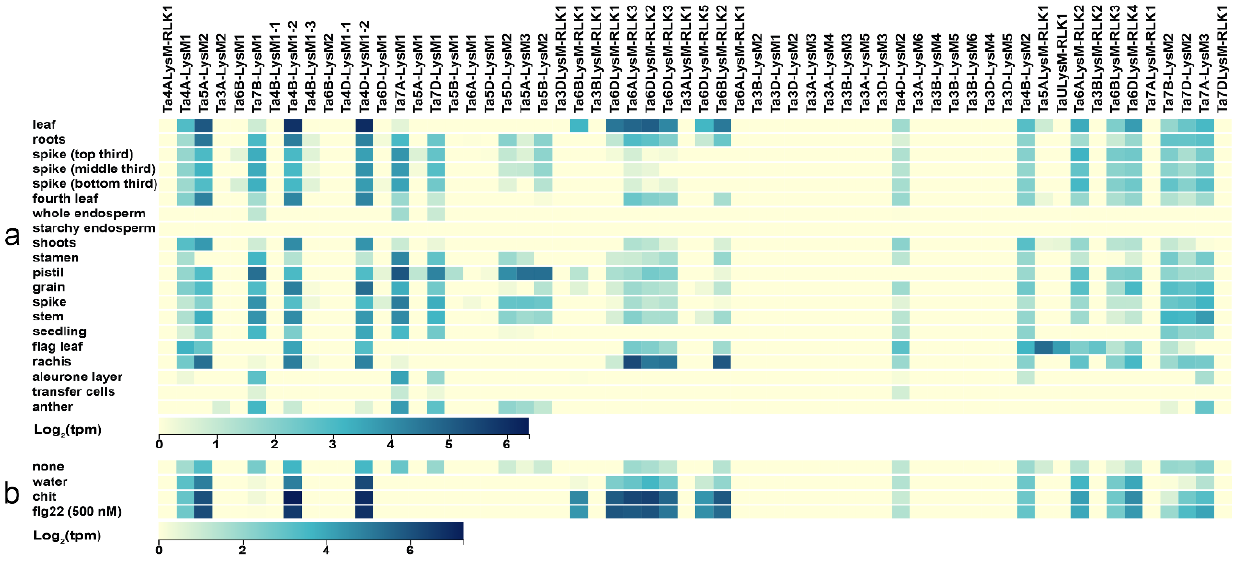
Figure 8. Expression of LysM genes in wheat. ( a ) Heat map of expression data in different Chinese spring tissues. ( b ) Heat map of expression data for different treatments. The blue color stands for high expression and the yellow color represents low expression. Water: water treatment; none: no treatment; chit: chitin; flg22: a polypeptide of flagellin proteins.